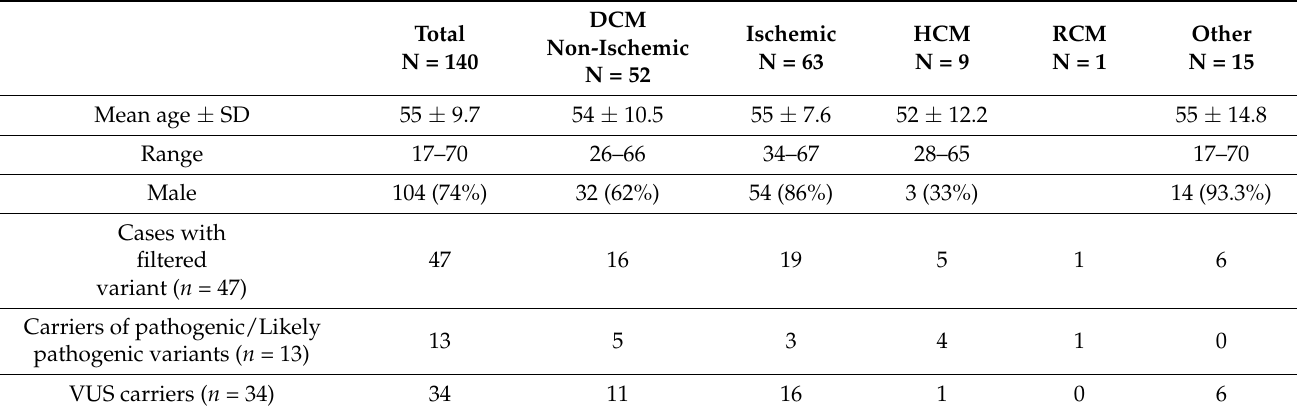
Table 1. Main characteristics of the 140 patients. The filtered variants identified in the primary analysis ( n = 48) were found in 47 patients, with 4 cases harboring 2